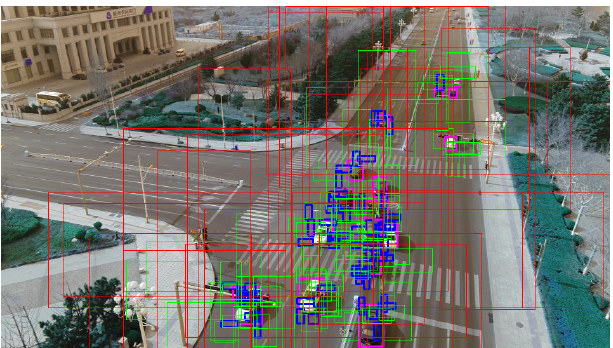
Figure 9. Example of Multi-scale Balanced Sampling Results of FPN, Libra RCNN and Multi-scale